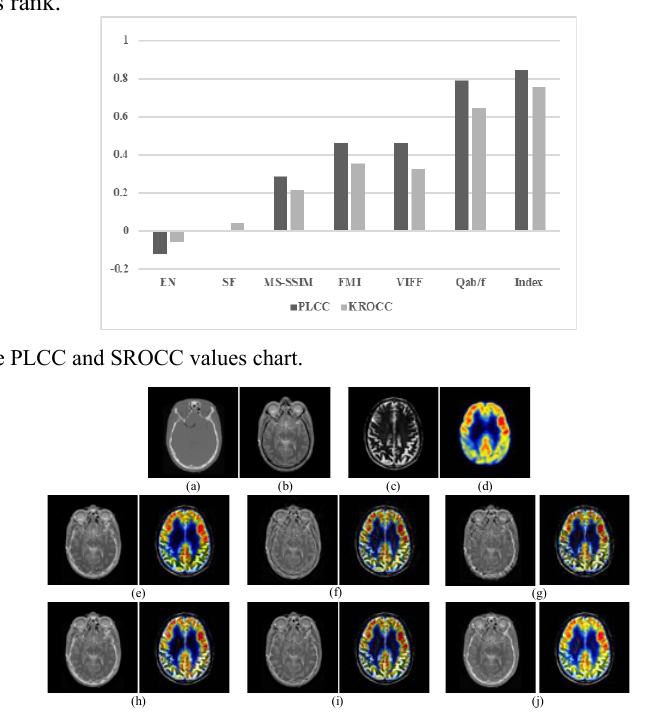
Figure 3. Comparison of image fusion result. (a) and (b), (c) and (b) are CT and MR-T1, MR-T2 and PET images respectively scanned along the axial plane of human brain, and (e) -(j) successively are fusion images obtained by CNN, CVT, DWT, LP, NSCT and NSST_PAPCNN fusion algorithms Table 1. Comparison results of different fusion algorithms and evaluation indexes of fusion